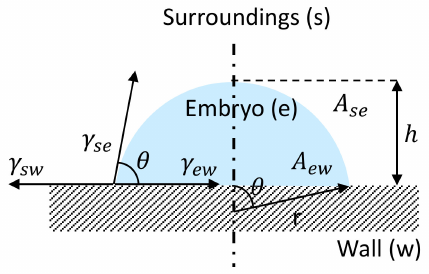
Figure 5. Schematic representation of embryo growth during heterogeneous nucleation on a hy- drophilic